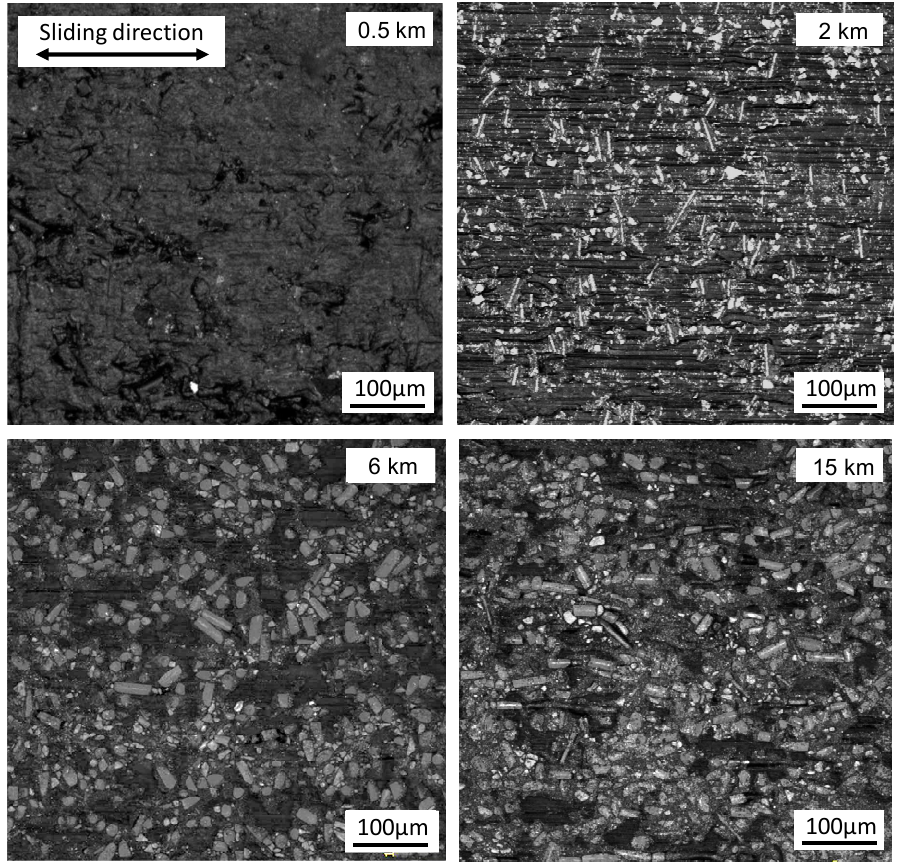
Figure 7. The wear evolution of the GFRPTFE sliding against duplex steel at 100 °C.